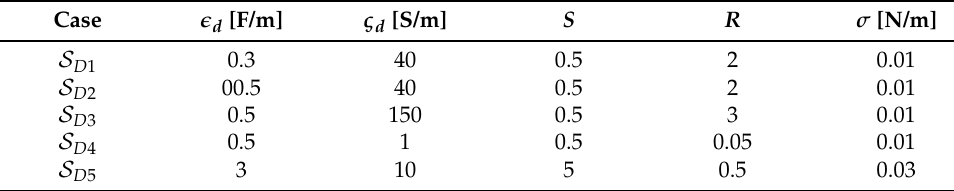
Figure 7. Pressure distribution across the left side of the droplet and the vector velocity contours inside and outside of the droplet on the right side. The red to blue colors indicate high to low pressure region. Table 3. Simulation parameters for EHD cases using small deformation